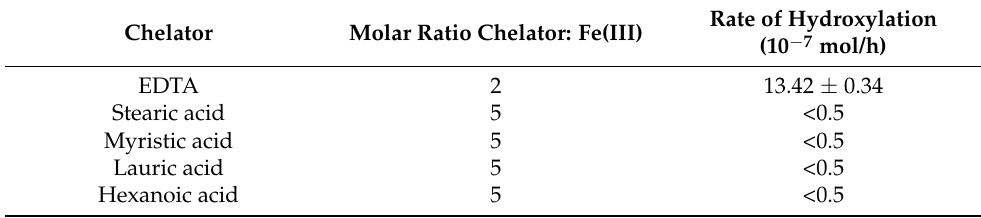
Table 2. Rate of NPBG hydroxylation by fatty acids in the presence of iron(III). Chelator Molar Ratio Chelator: